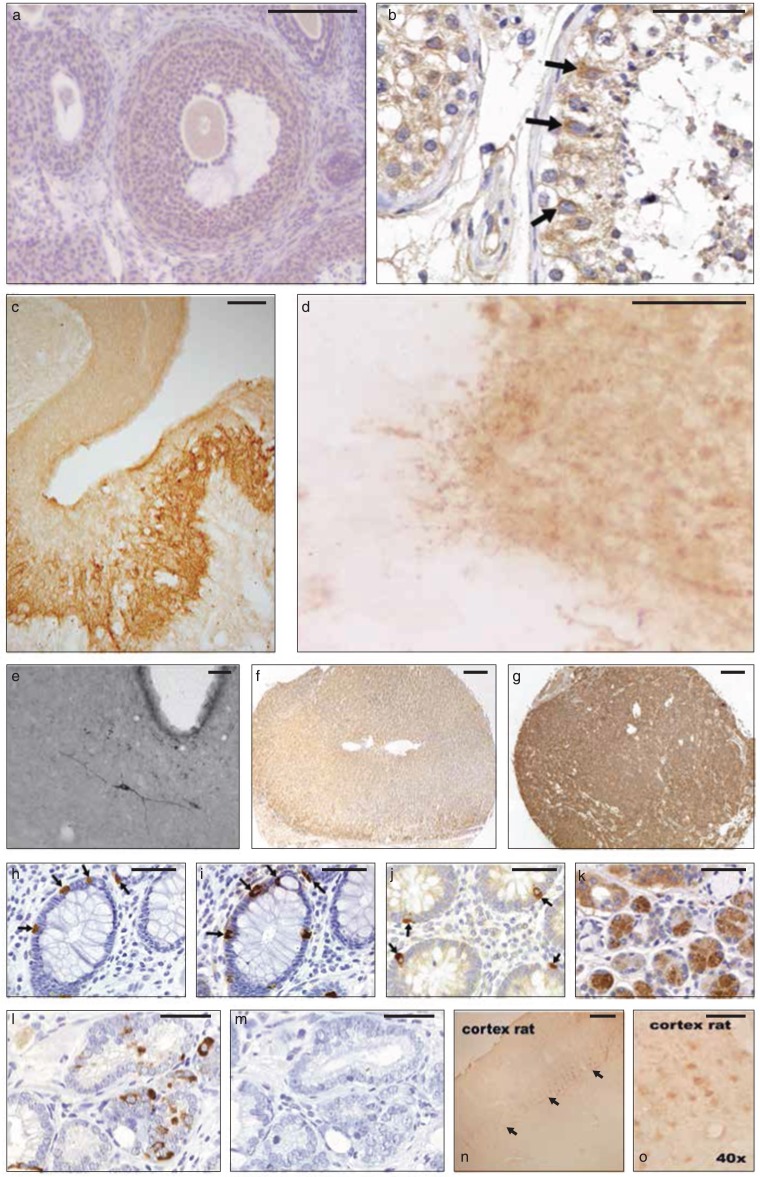
Mammalian IHC.Rabbit anti-EPL001 antiserum ER88 used unless otherwise stated, with dilution in brackets. (A) Ovary (rat) showing moderate staining (brown) (1/1,000). (B) Testis (human), epithelial germ cell staining arrowed (1/200). (C) Median eminence (sheep), staining of palisade (neuroendocrine) region (rabbit antiserum ER87, 1/1,000). (D) Median eminence (sheep, higher power), showing axonal beading (1/1,000). (E) Hypothalamus (rat), showing immunopositive neuron in the retrochiasmatic nucleus, with third ventricle appearing as white bay (goat antiserum, 1/1,000). (F) Adrenal (human, normal, medulla not shown), staining judged as negative (1/200). (G) Adrenal tumour (human pheochromocytoma), staining judged as strongly positive (1/200). (H) Colon (human) showing enteroendocrine cells (arrowed) (1/200). (I) Colon (human), serial section of H showing staining for CgA (1/200). (J) Appendix (human), showing neuroendocrine cells (arrowed) (1/200). (K) Salivary gland (human, ×40), ducts showing heavy staining (brown) (1/200). (L) Prostate (human) showing basal luminal neuroendocrine cells (1/200). (M) Prostate (human), serial section of L subject to preabsorption with EPL001 peptide at 0.5 mg/ml (1/200). (N) Cerebral cortex (rat), showing immunostaining in layer 5, arrowed (1/1,000). (O) Cerebral cortex (rat, higher power), showing layer 5 pyramidal cells (1/1,000). Scale bars ∼50 μm, except those for C, E, G and N, which are ∼200 μm.